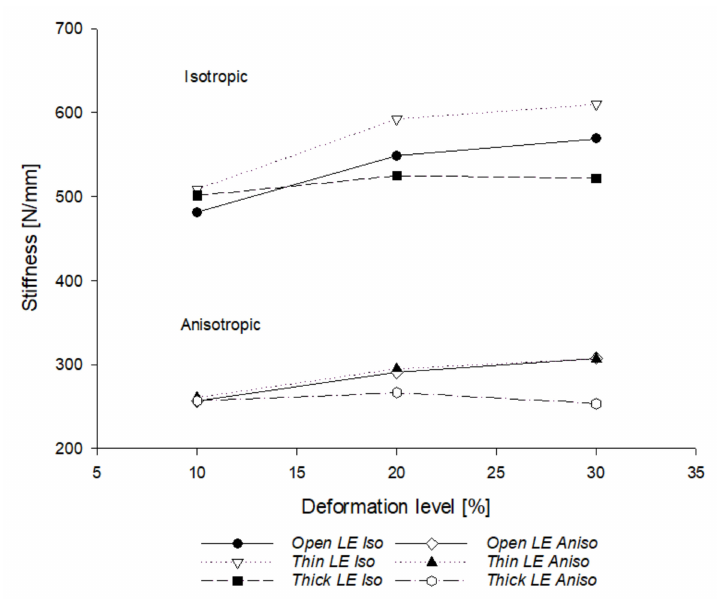
Figure 12. FEM simulations with linear elastic material: isotropic vs.